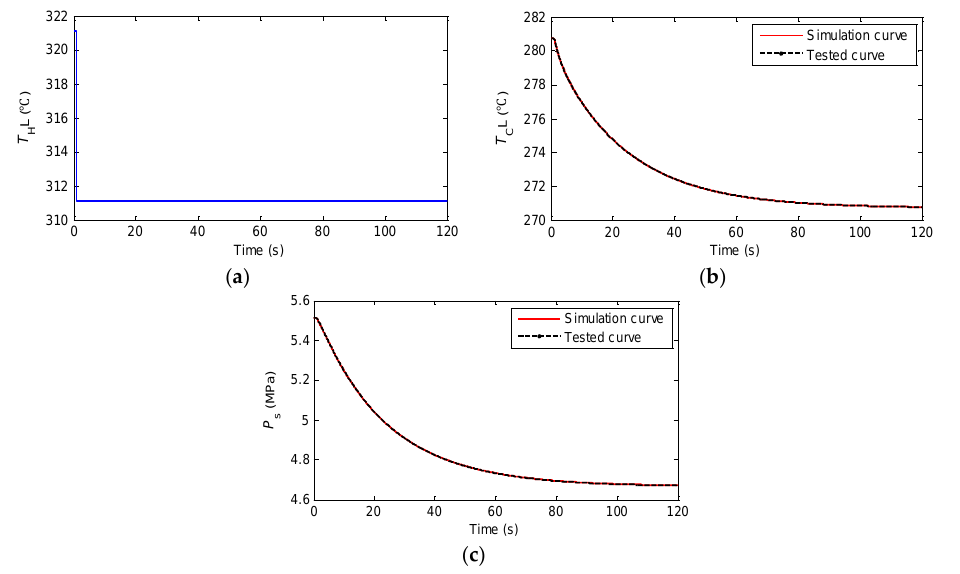
Figure 11. Steam generator module simulation comparison. ( a ) Input change of T HL ; ( b ) output change of T CL ; and ( c ) output change of P s .